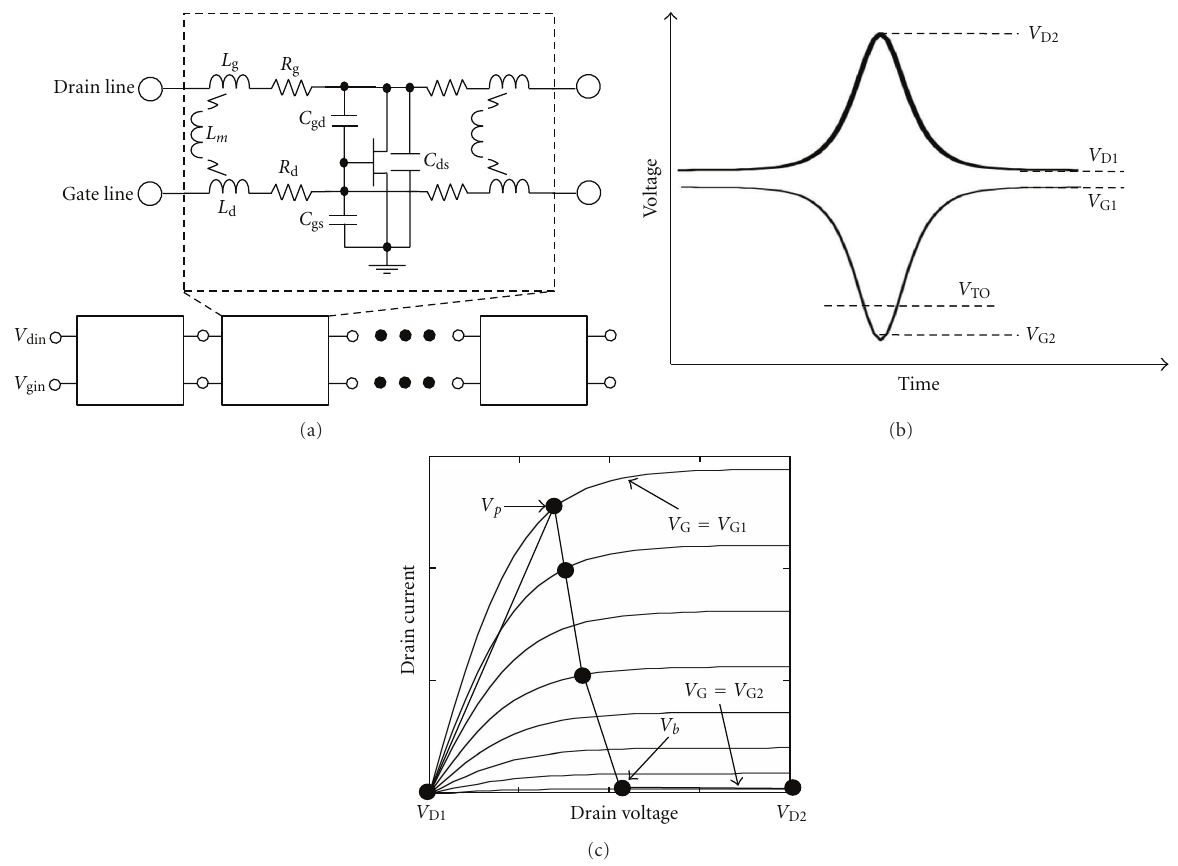
Figure 2: Setup of TWFETs for shortening traveling pulses. (a) A representation of a TWFET, (b) the signal application to a TWFET and (c) the equivalent current-voltage relationship of an FET for a pulse traveling in the drain line.